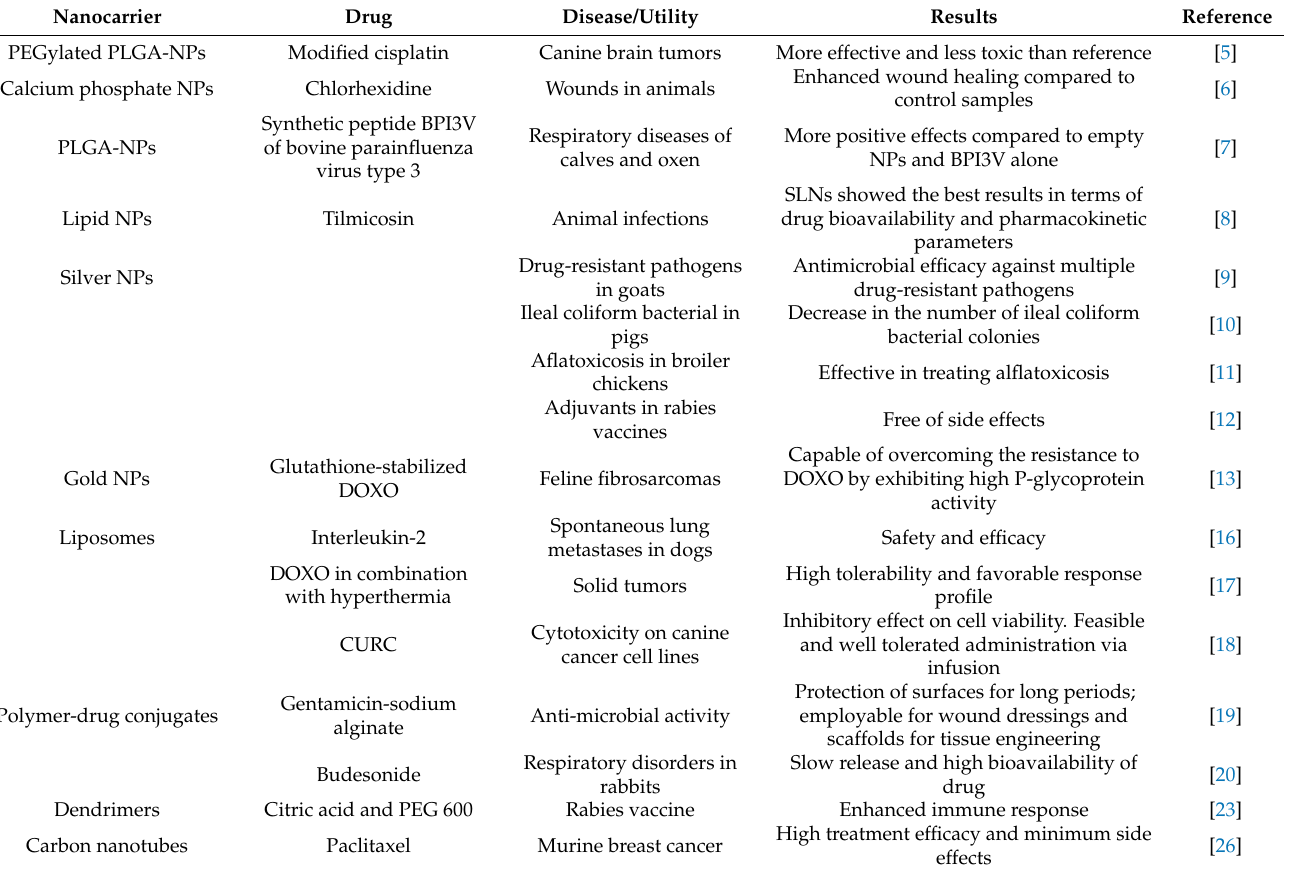
Table 1. Studies describing the use of nanocarriers in veterinary